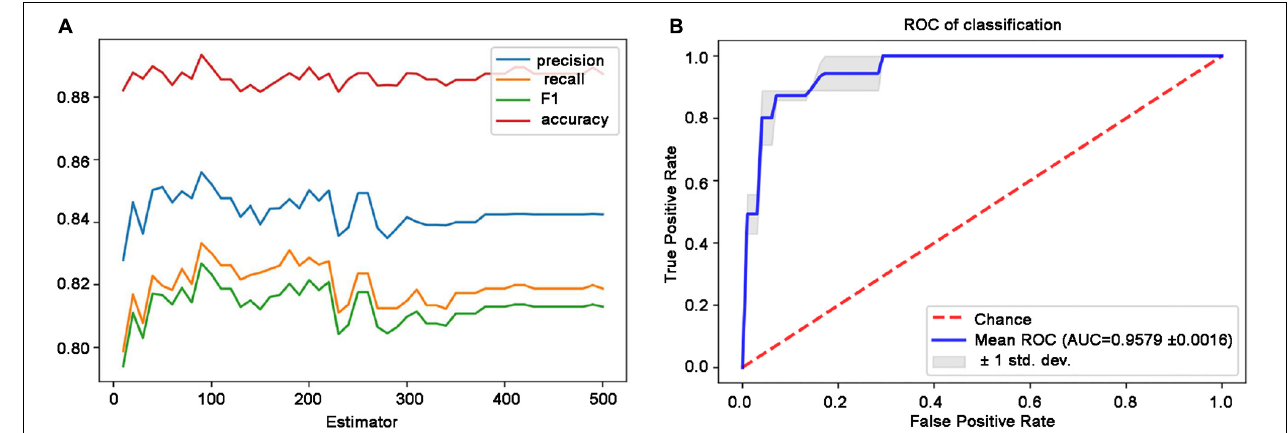
FIGURE 3 | Performance of the simplified RF model. (A) Classification performance with respect to the distinct number of decision trees. (B) ROC curves and the AUC of the RF model are based on the 90 decision trees. Blue line denotes the average ROC curve, and the shaded area indicates the lower and upper limits of the AUC in the 10-fold cross-validation. AUC, area under the ROC curve; RF, random forest; ROC, receiver operating